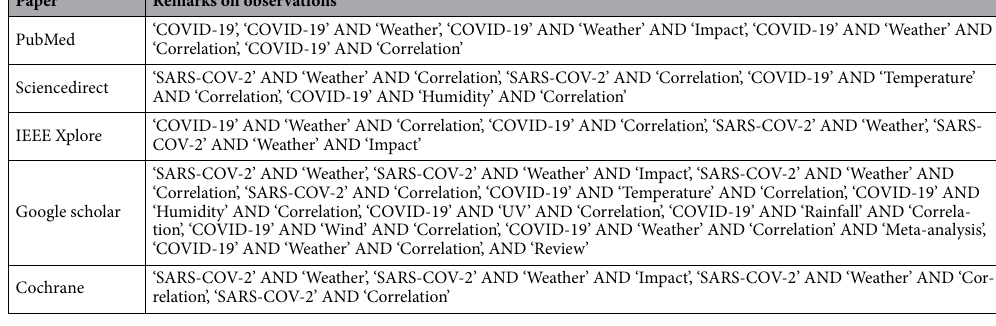
Table 1. Keywords used for literature